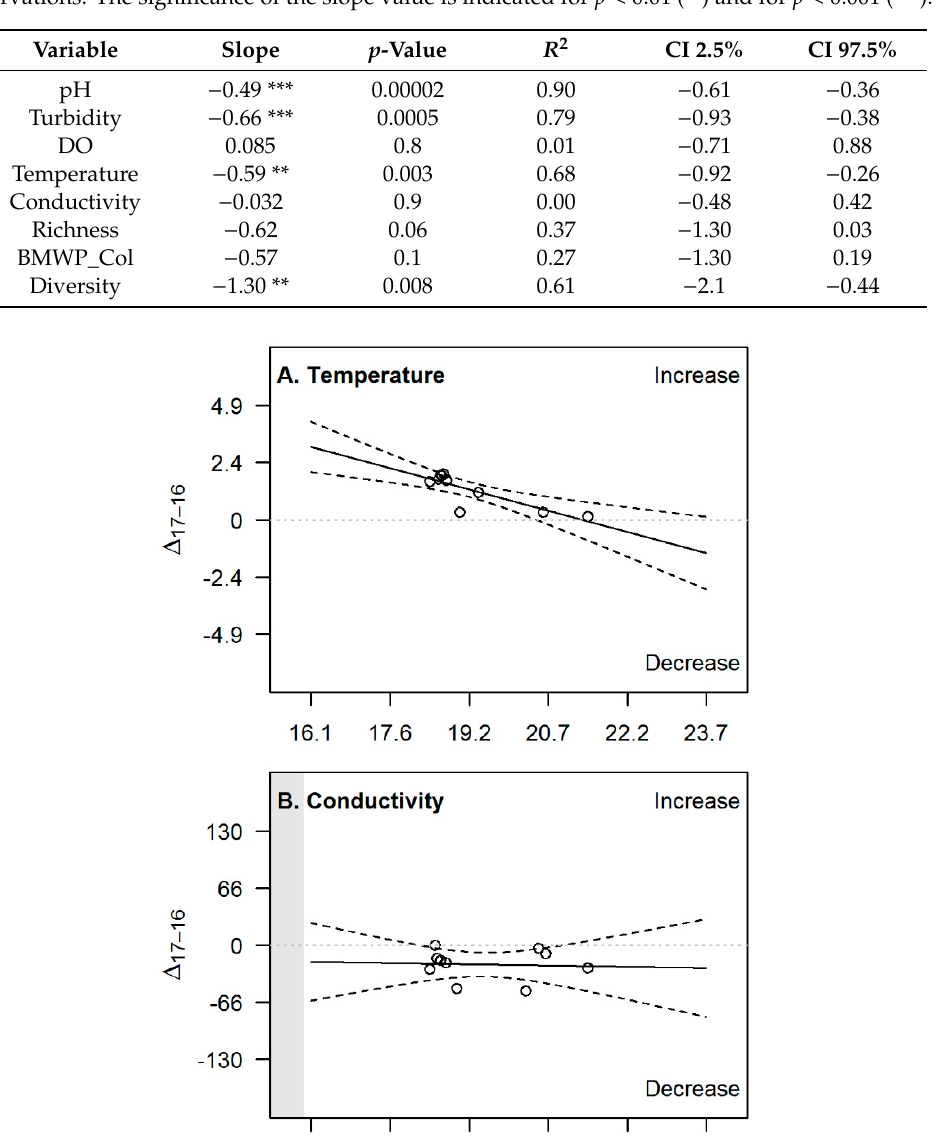
Table 3. Results of linear analyses relating the observed di ff erences between 2016 and 2017 ( ∆ 17 − 16 ), with the observations made in 2016 as represented in Figures 4–6. Slope values are given with their accompanying p -value and 95% confidence interval (CI). The R 2 value describes the model fit to the observations. The significance of the slope value is indicated for p < 0.01 (**) and for p < 0.001 (***).